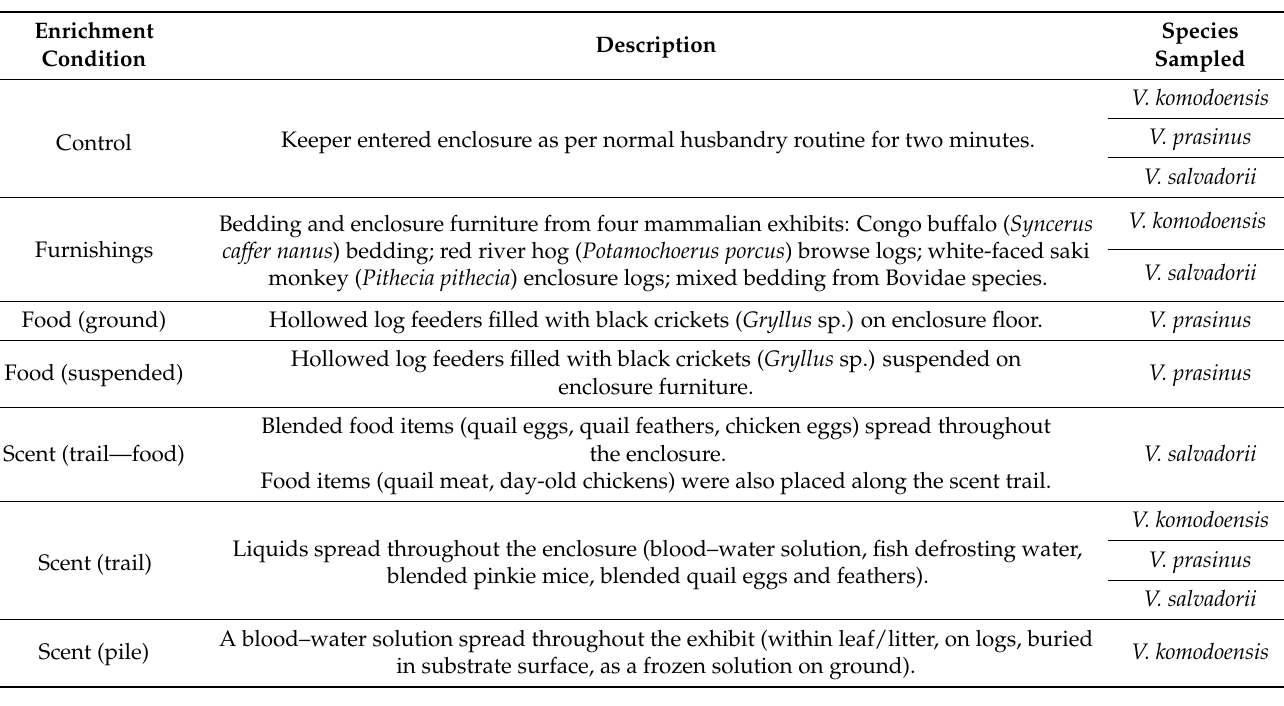
Enrichment Condition